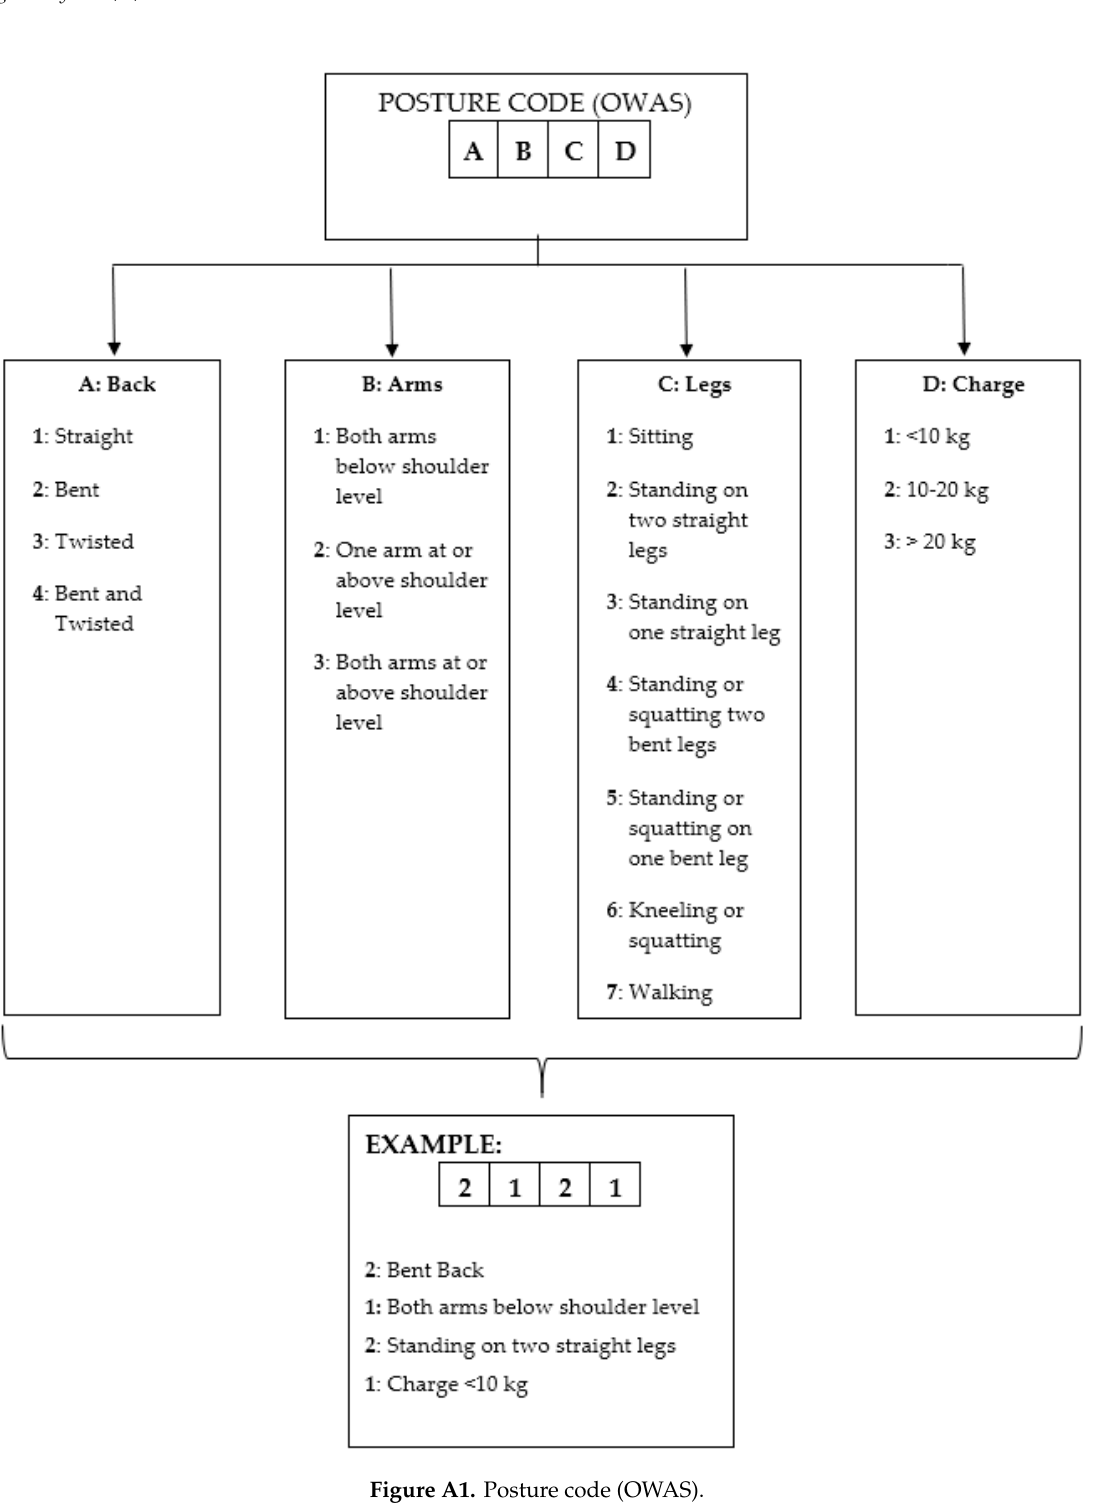
Figure A1. Posture code (OWAS).